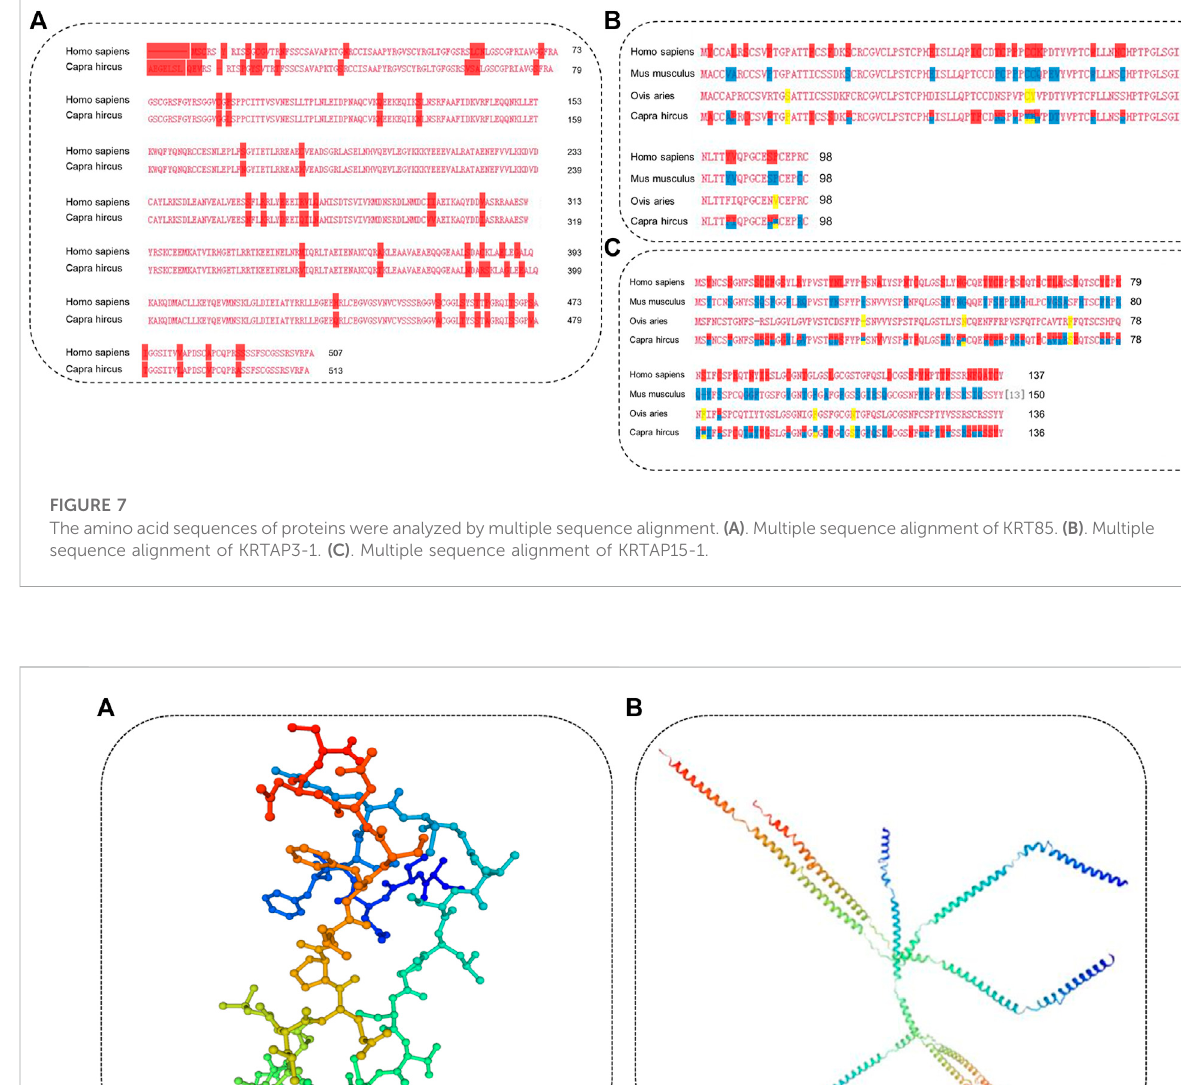
Mus musculus and Ovis aries (Figure 7). The red mark in Figure 7 represents the differentially expressed sequence of Capra hircus and Homo sapiens . The blue mark denotes the site difference in expression from that of Mus musculus , and the yellow mark represents the site with a difference from the sequence of Ovis aries . The three-dimensional structures of KRT85 and KRTAP3- 1 were established by the comparative protein modeling program SWISS-MODEL (Figure 8).